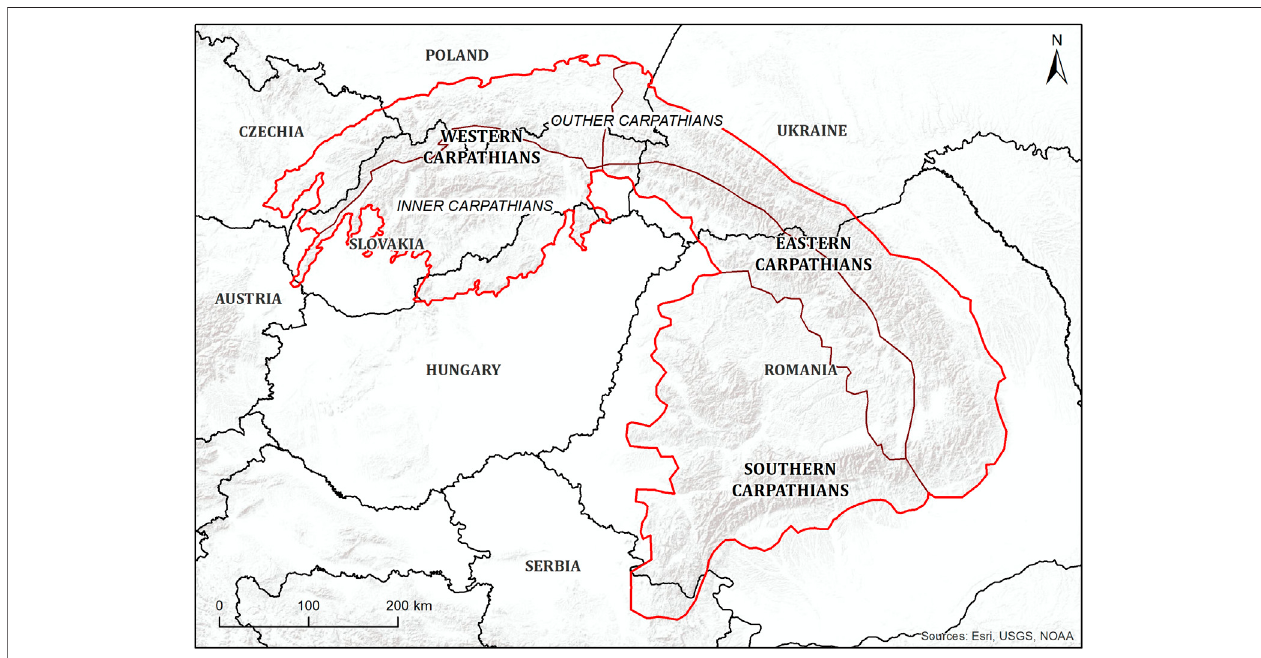
FIGURE 1 | Location of the Western Carpathians. Source: own study based on Kondracki, 1978.